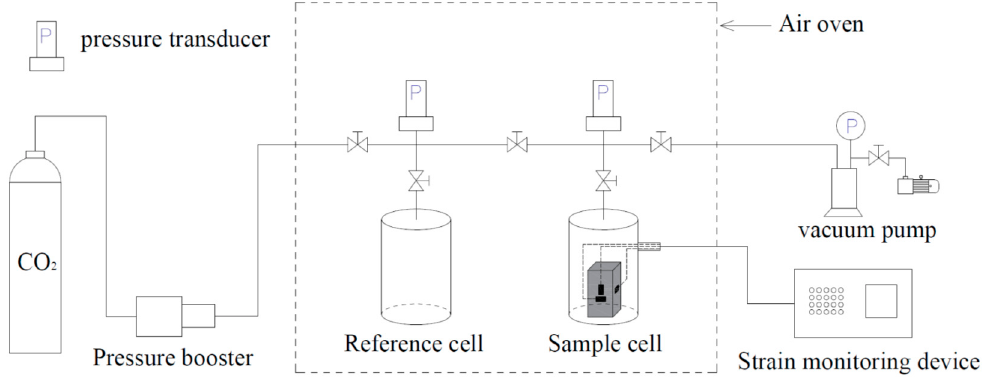
Figure 5. Schematic diagram of CO 2 adsorption experimental apparatus.